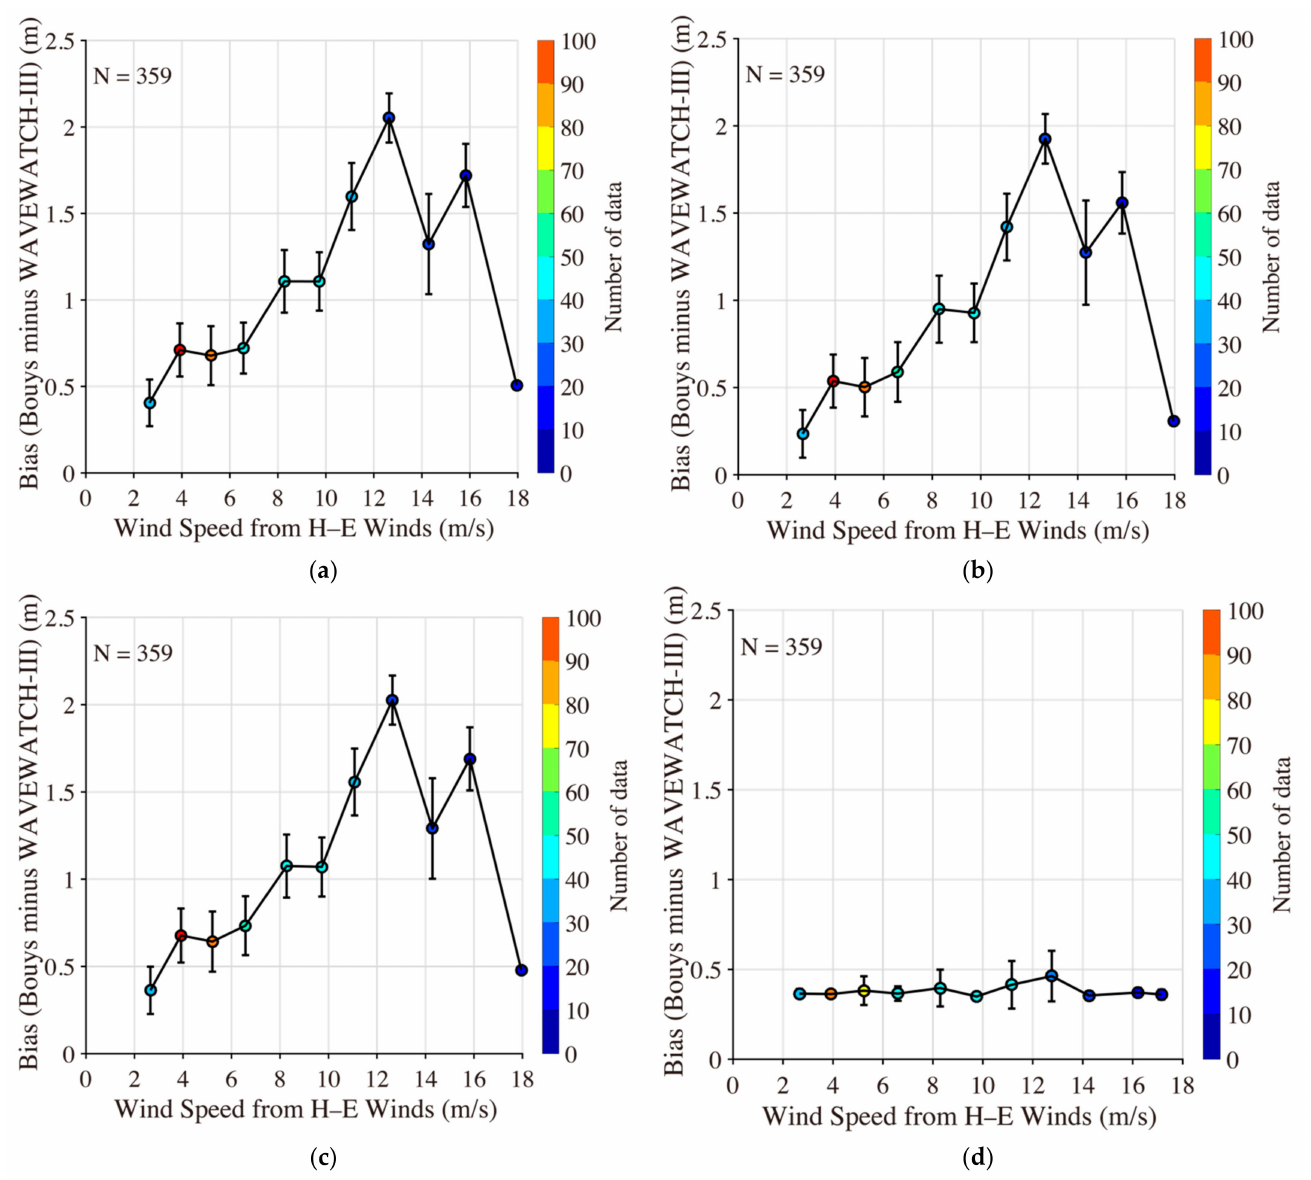
Figure 12. The statistical analysis of bias (buoys minus WW3-simulated H s ) compared with the wind speeds from composited H–E winds using the parameterizations in [2] ( a ), [57] ( b ), [59] ( c ), and this study ( d ), in which the error bars represent the standard deviation for a 1 m bin of H s up to about 10